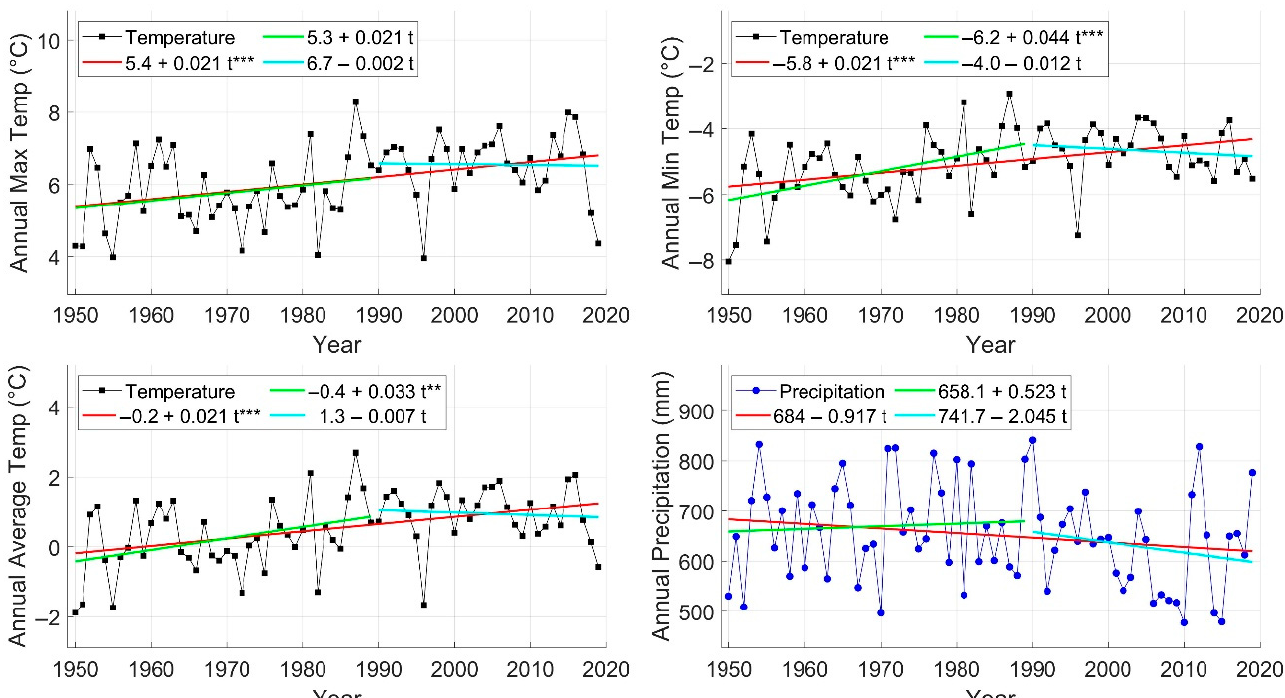
Figure 4. Climate trend analysis results for the middle ARB. The statistically significant slopes are marked by stars: (* = 90%), (** = 95%), (*** = 99%).